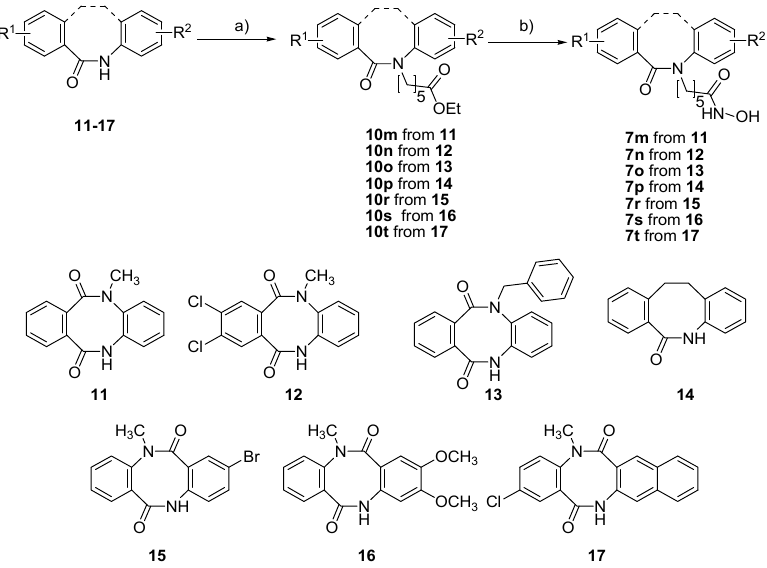
Scheme 2. The synthesis of the Series 3 compounds 7 m – t : ( a ) Br(CH 2 ) 5 COOEt, NaH, DMSO, 18 h, R = Me, Et; ( b ) NH 2 OH × H 2 O, THF, MeOH, 18 h,